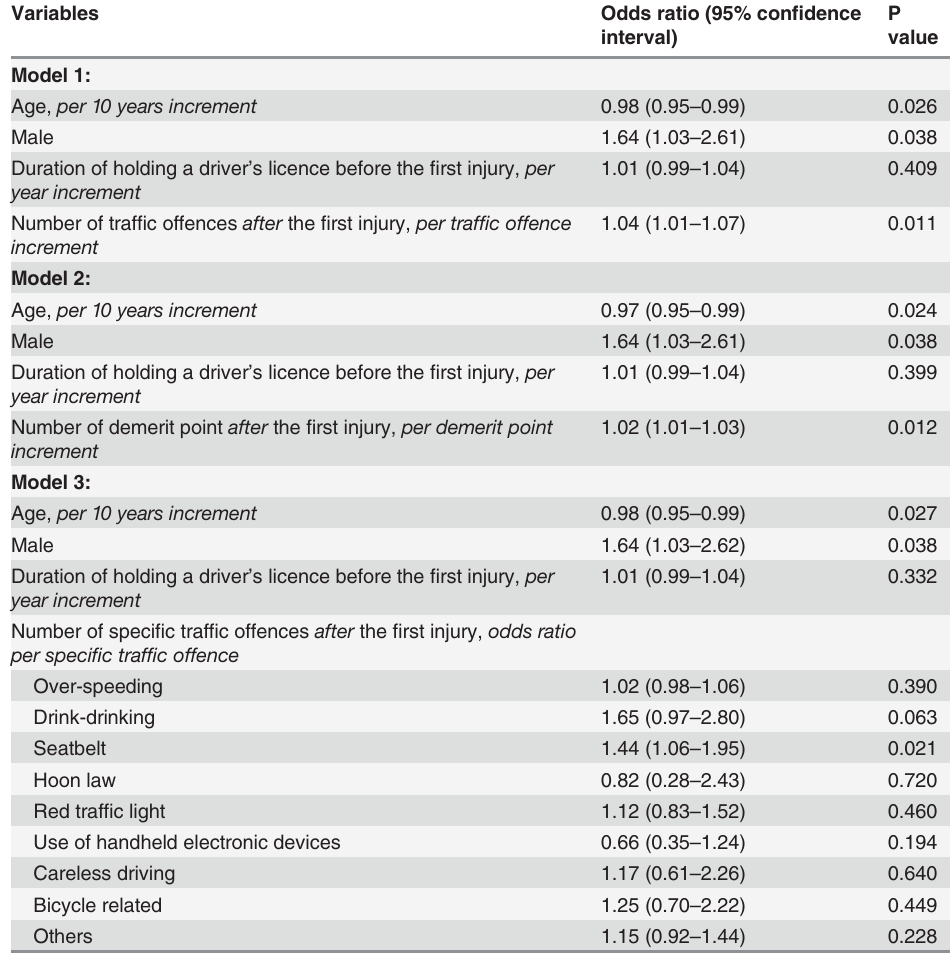
P interval) value